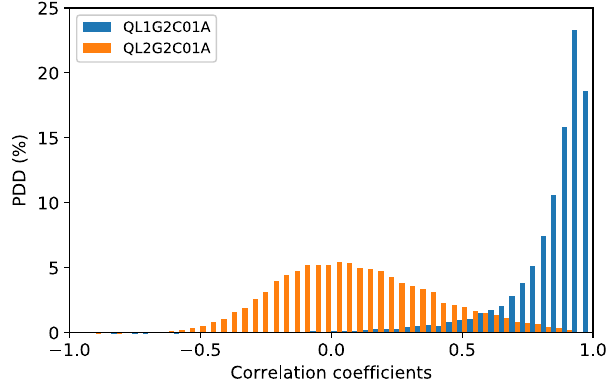
patterns and two unit vectors v 10 ; 11 . The reproducibility further confirms our experiment